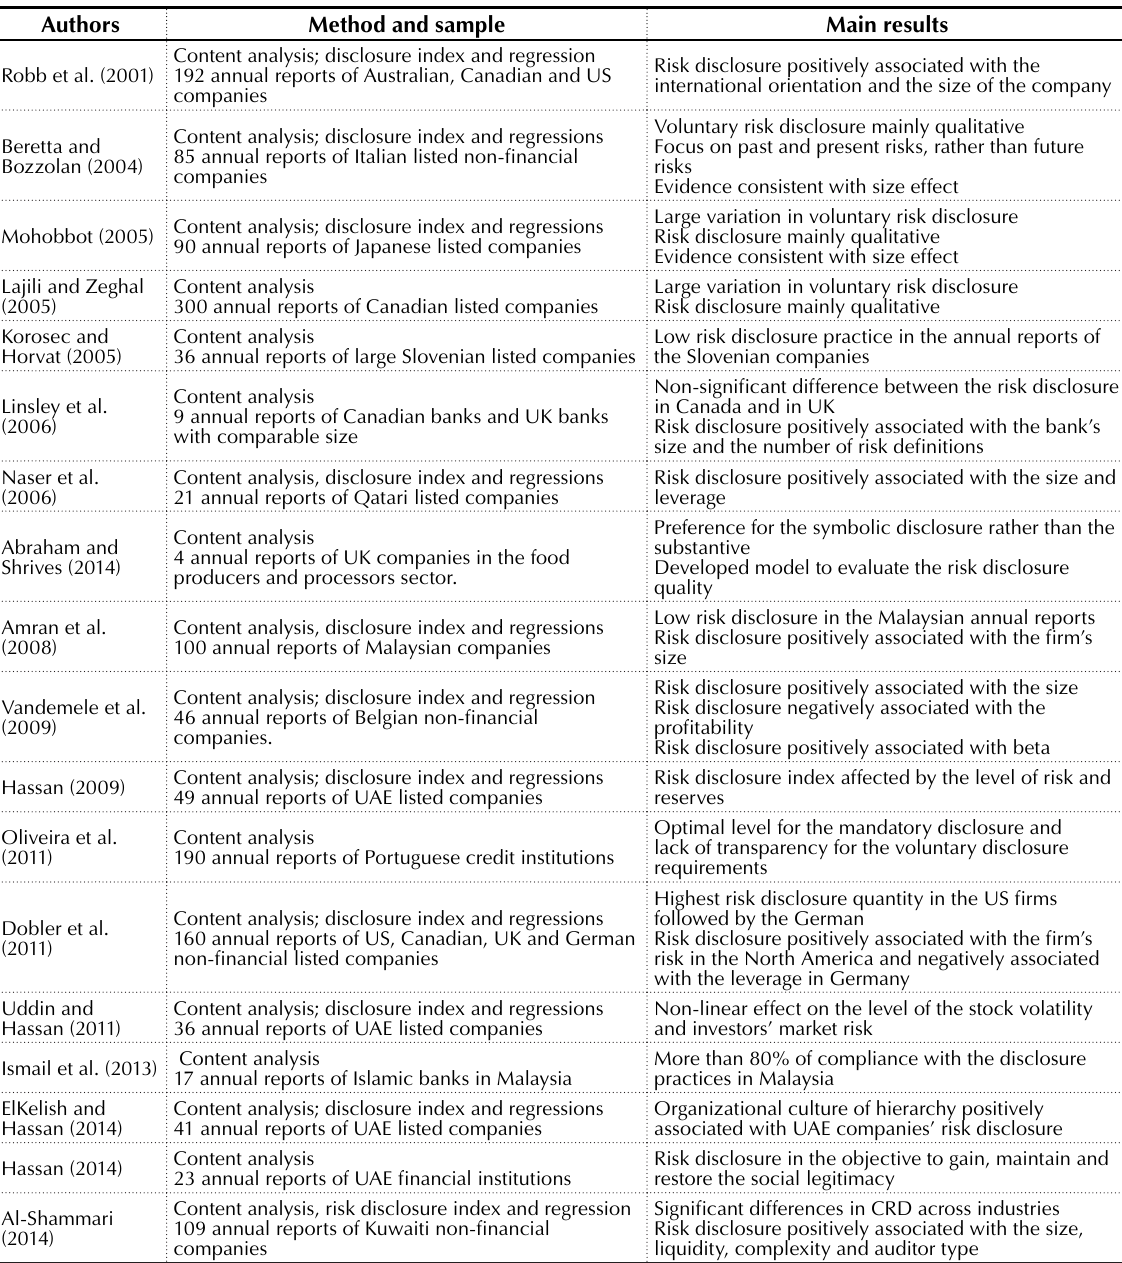
Source: based on Vandemele et al. (2009), supplemented with other